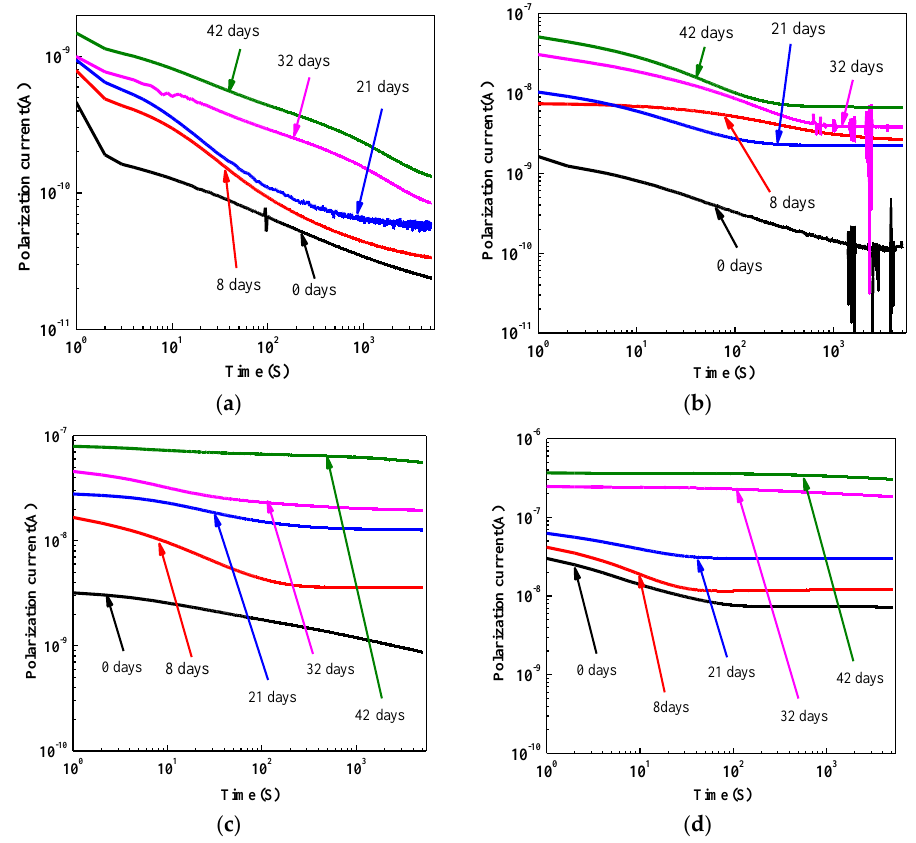
Figure 2. Polarization current results of oil-impregnated pressboards with different ageing times ( a ) water content 1%; ( b ) water content 2%; ( c ) water content 3%; ( d ) water content 4%.